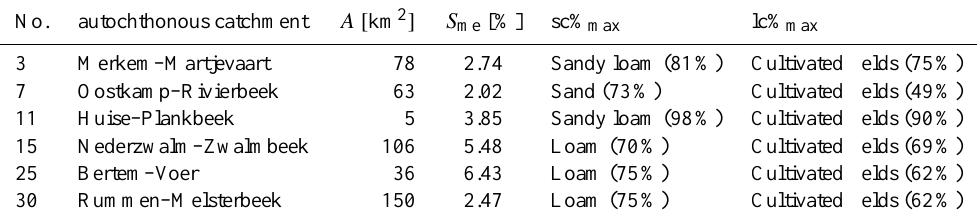
Table 2. Overview of the selected autochthonous catchments and corresponding properties. A is the drainage area of the catchment. S me is the local slope (mean slope of a grid cell) averaged over all grid cells within the catchment. sc% max and lc% max are respectively the soil class and land cover class with the highest relative area within the